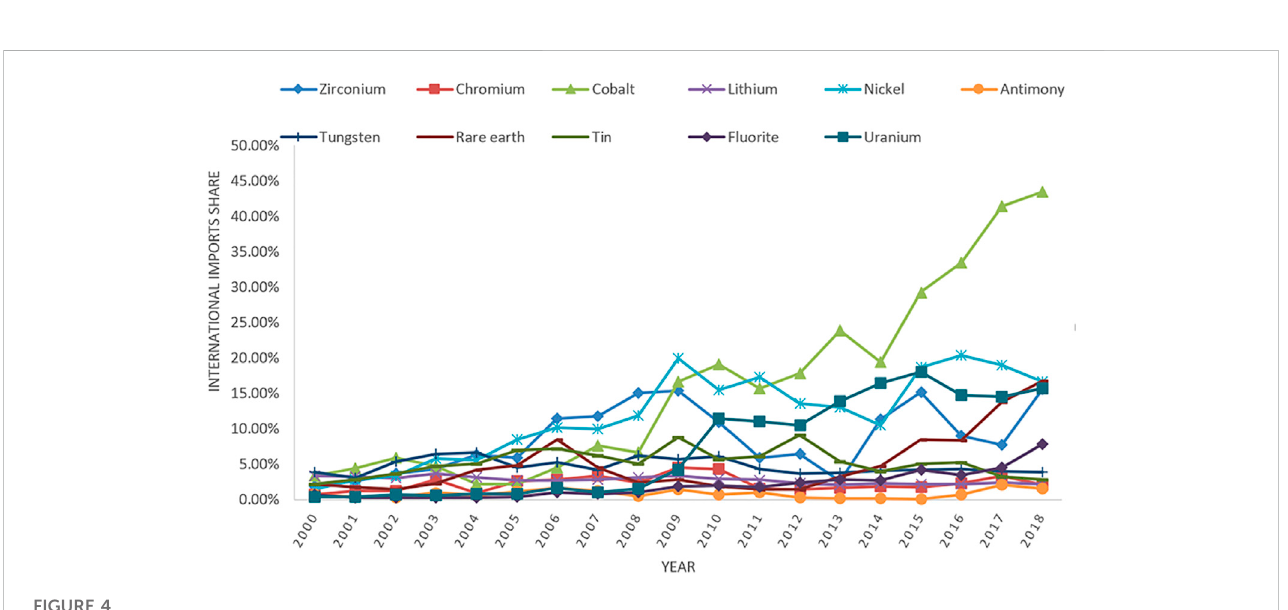
FIGURE 4 Imports shares of China ’ s strategic and critical mineral